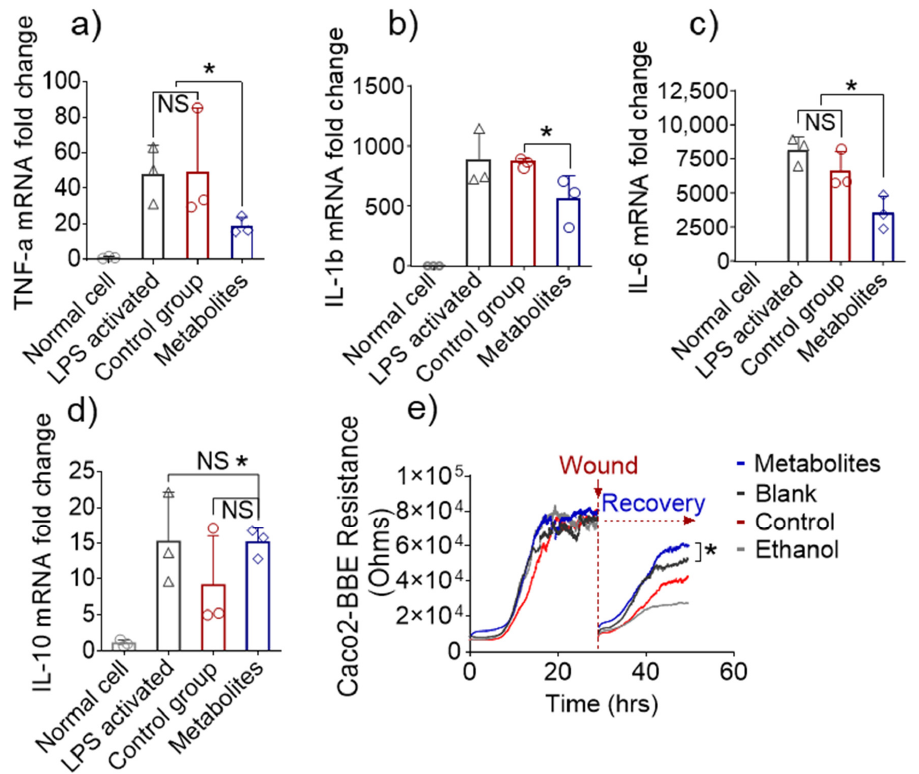
Figure 5. In vitro anti-inflammatory and wound-healing effects. ( a ) Fold-changes in the expression of TNF- α , ( b ) IL-1 β , ( c ) IL-6, and ( d ) IL-10 genes in inflamed Raw 264.7 cells treated with microbiota- derived metabolites from 6S/nLNP-treated mice or normal microbiota-derived metabolites ( n = 3; * p < 0.05 ( a – d ), NS: non-significant). ( e ) Representative graph showing the effects of microbiota- derived metabolites from 6S/nLNP-treated mice or normal microbiota-derived metabolites on the healing of wounded Caco-2 BBE cells ( n = 3; * p <